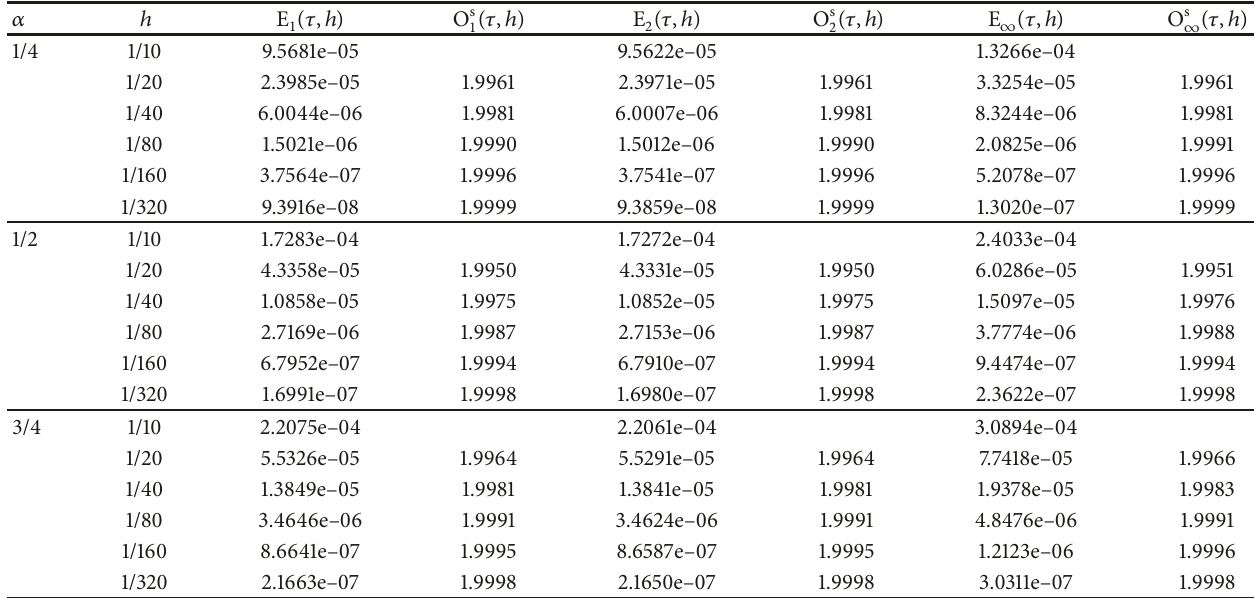
Table 3: The errors and the temporal convergence orders of the compact difference scheme (23) for Example 2 (𝜏 = 1/100) .